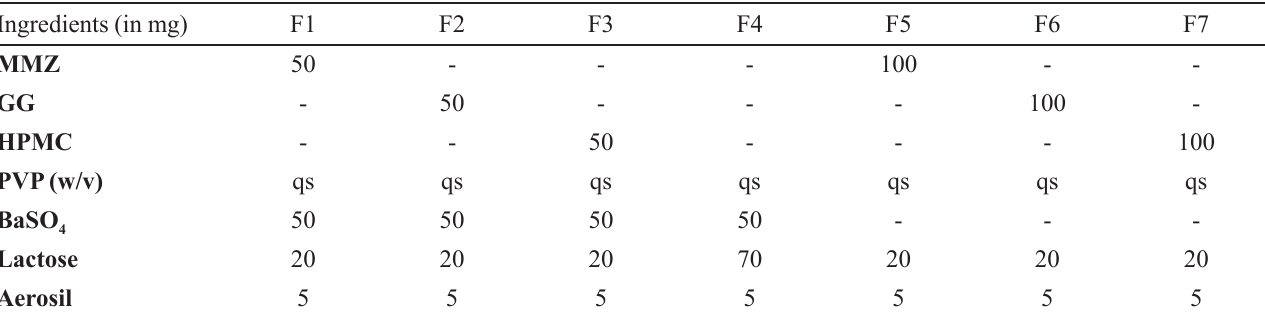
TABLE I - Formulation code for the X-ray and physical characterization of mucilage tablet Ingredients (in